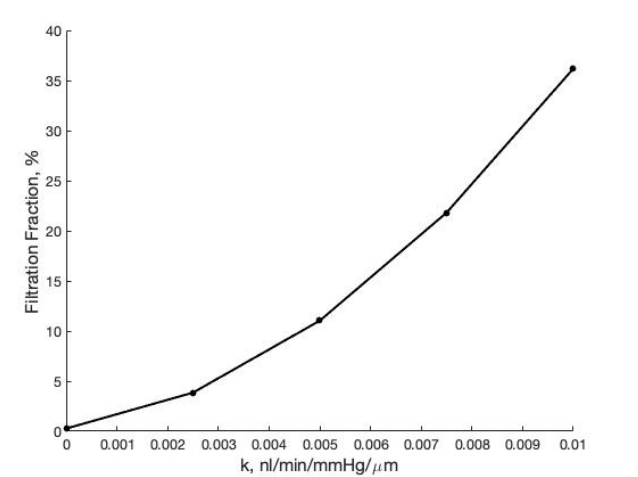
Figure 10. Filtration fraction, FF as a function of the hydraulic conductivity k of the vessel wall which ultimately dictates the value of β